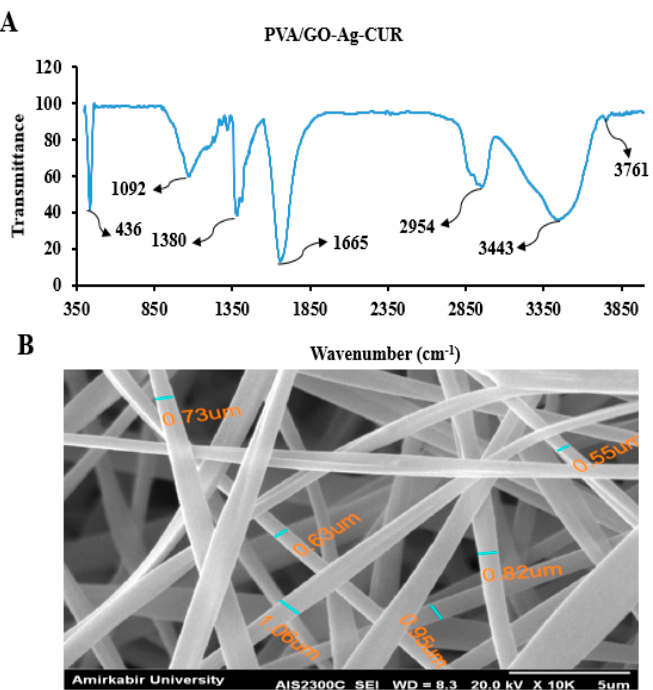
Figure 4. ( A ) FTIR spectrum of PVA/GO-Ag-CUR ( B ) SEM image of PVA/GO-Ag-CUR nanofibers.